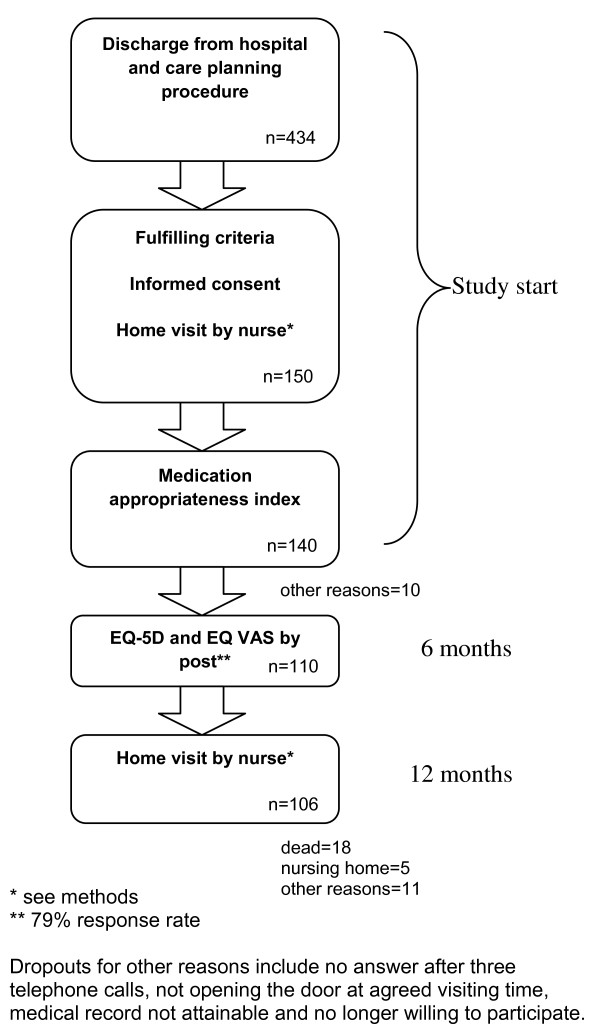
Study flow chart.